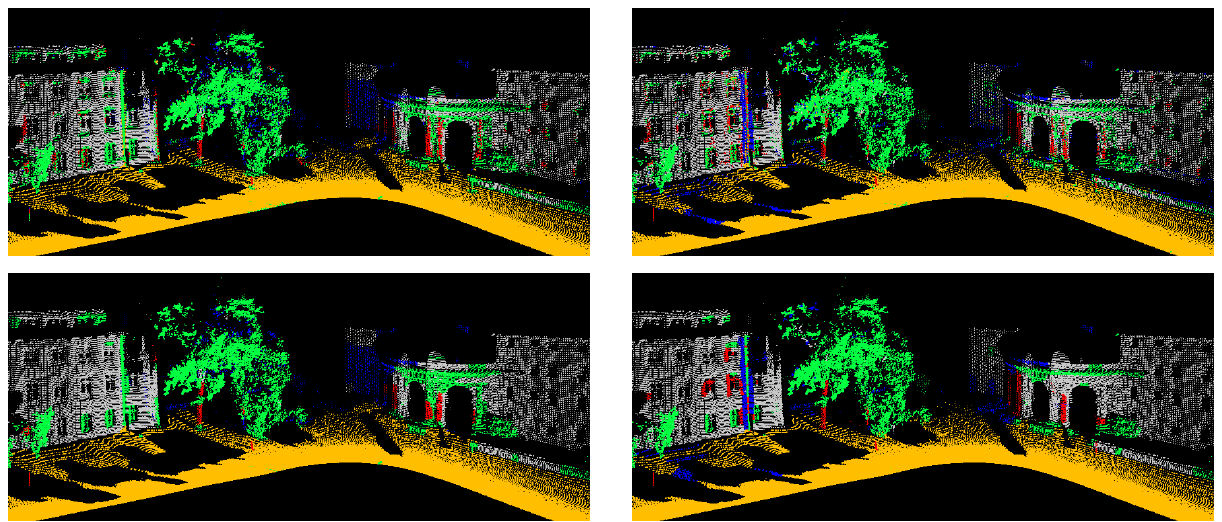
Figure 1. Classified 3D point clouds for the neighborhoods {N 50 , N opt ,λ } (left and right column) and the classifiers (cid:8) RF 200 , CRF 5 200 (cid:9) (top and bottom row) when using a standard color encoding ( wire : blue; pole / trunk : red; fac¸ade : gray; ground : brown; vegetation : green). Note the noisy appearance of the results for individual point classification (top